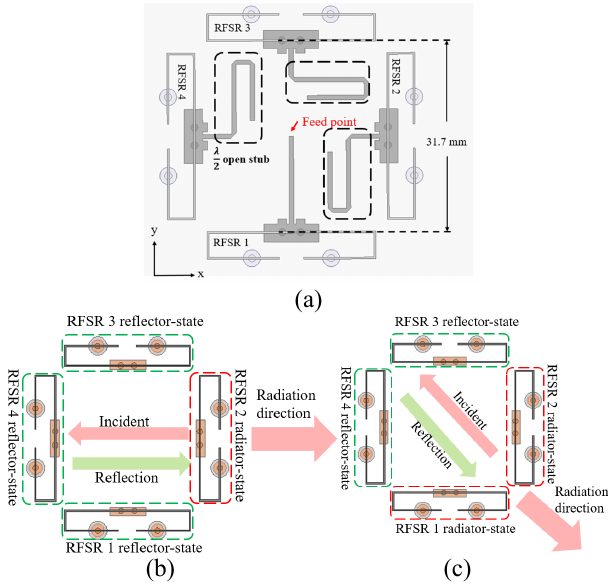
Figure 9: (a) Geometry of the RFSR antenna. (b) Radiation mechanism for φ = 0°, 90°, 180°, and 270°; and (c) radiation mechanism for φ = 45°, 135°, 225°, and